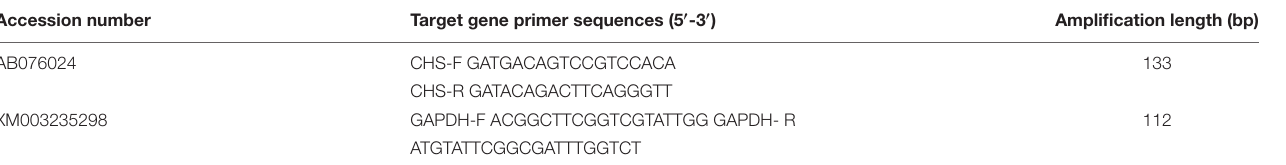
TABLE 1 | Primer sequences of qRT-PCR amplification.